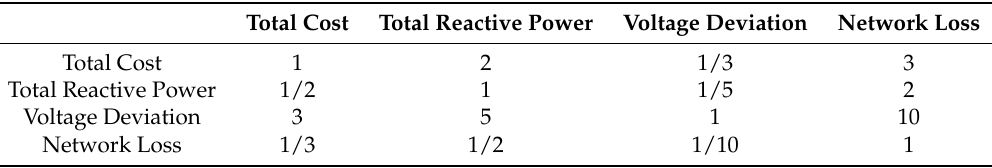
Table 1. A typical pairwise comparison matrix